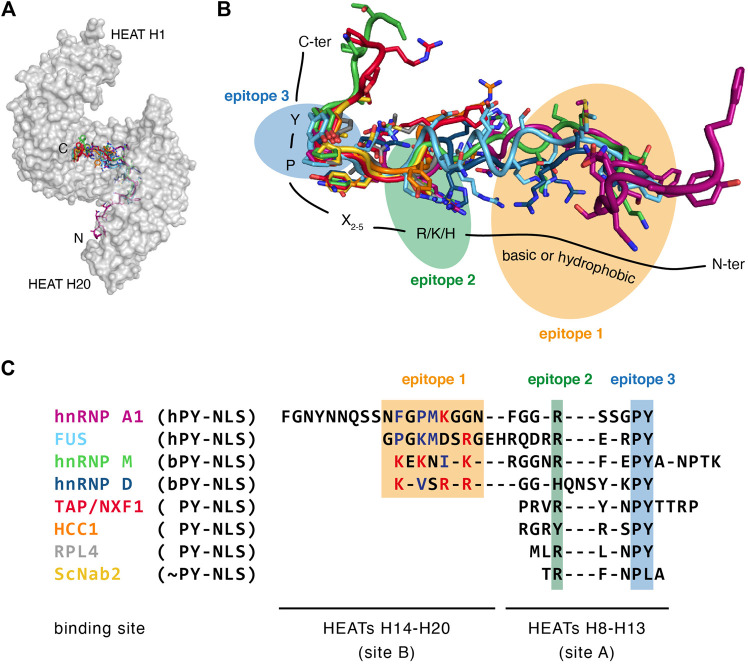
PY-NLS recognition by Transportin-1. (A) A common binding site for PY-NLSs with the C-terminal arch of Trn1. Trn1 is shown in gray as a transparent surface to facilitate PY-NLS observation. The PY-NLSs are displayed with different colors (see below), and all share the same N-ter to C-ter orientation. (B) Structural superposition of PY-NLSs from the following proteins: hnRNP A1 in purple [PDB code 2H4M (Lee et al., 2006)], FUS in light blue [PDB code 4FDD (Zhang and Chook, 2012)], hnRNP M in green [PDB code 2OT8 (Cansizoglu et al., 2007)], hnRNP D in dark blue [PDB code 2Z5N (Imasaki et al., 2007)], TAP/NXF1 in red [PDB code 2Z5K (Imasaki et al., 2007)], HCC1 in orange (PDB code 4OO6), RPL4 in gray [PDB code 5TQC (Huber and Hoelz, 2017)], ScNab2 in yellow [PDB code 4JLQ (Soniat et al., 2013)]. The structures were superimposed on the Trn1 proteins, but for clarity they are not shown, and only the PY-NLSs are displayed as sticks. The three recognition epitopes are shown with colored ellipses. Epitope 1, which corresponds to a stretch of basic or hydrophobic residues, is highlighted in yellow. Epitope 2, which corresponds to a positively charged residue (R/K/H), is highlighted in green. Epitope 3, which corresponds to a proline–tyrosine dipeptide (PY) is highlighted in blue. (C) Structure-based alignment of the same PY-NLSs displayed on panel B. The PY-NLS sequences were aligned according to their relative position in the structures. Only residues actually observed in the structures are displayed. The three epitopes as described in panel B are highlighted with the same color code. Within epitope 1, hydrophobic residues are colored in blue, and positively charged residues are colored in red. hPY-NLS: hydrophobic PY-NLS. bPY-NLS: basic PY-NLS. PY-NLS: PY-NLS without a basic or hydrophobic stretch seen to interact with Trn1 in the structure. ∼PY-NLS: variation to the PY-NLS motif.